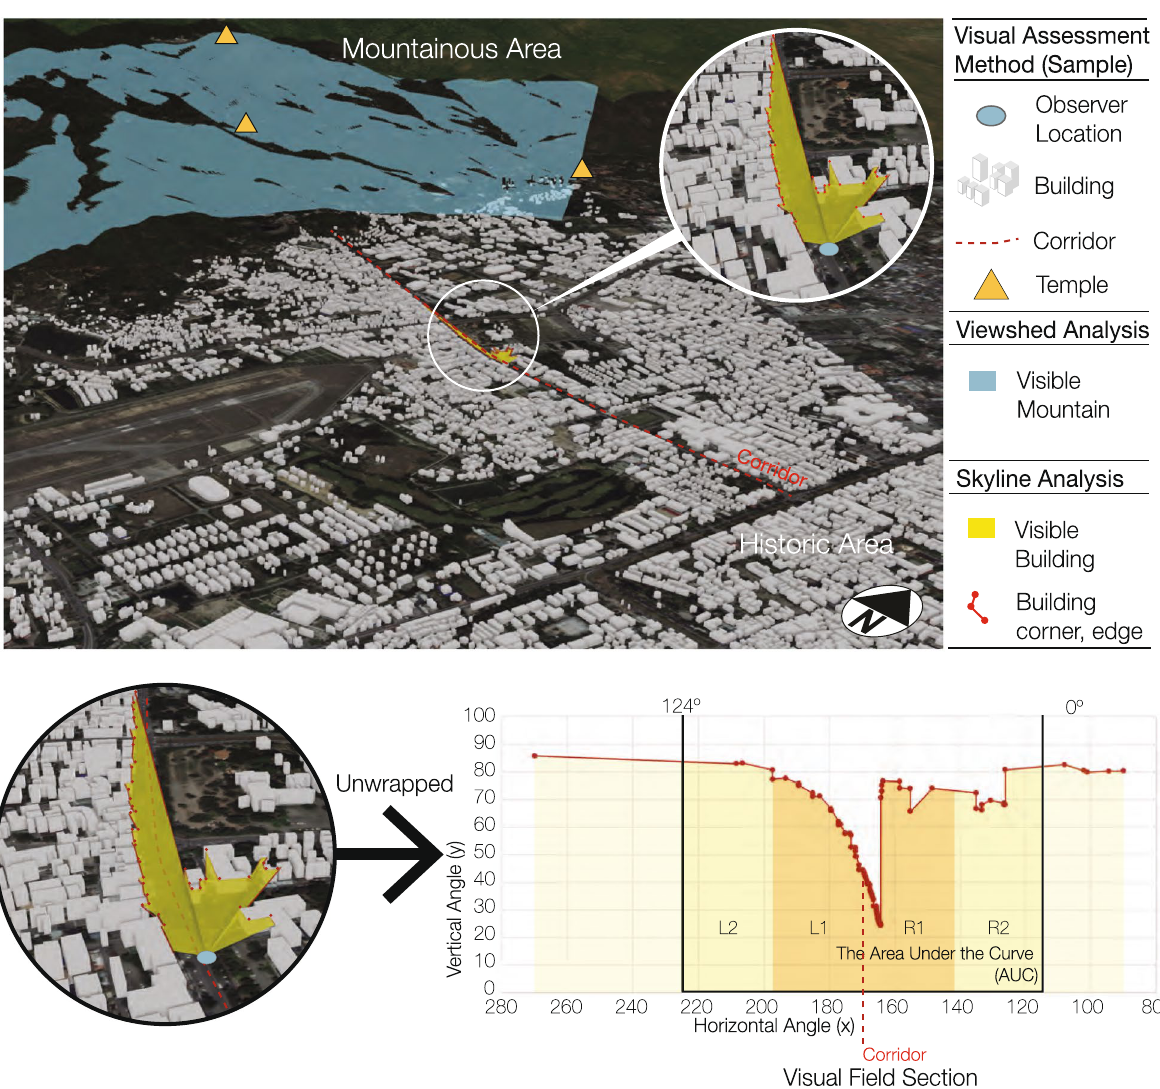
Fig. 4 Example of visible area measurement (Source: the authors)